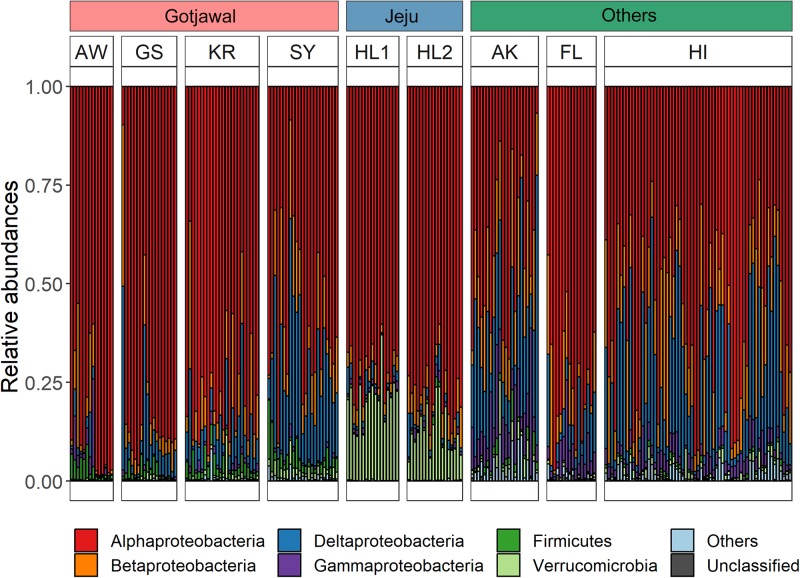
Bar graphs indicate six dominant phyla in three regions. Each bar of Gotjawal and Jeju are ordered by seasons. Others are Alaska (AK), Florida (FL), and Hawaii (HI) regions, where the soil layer is relatively thick, and represent boreal, subtropical/dry, and lower montane wet forest, respectively. Each phylum is indicated in a different color.